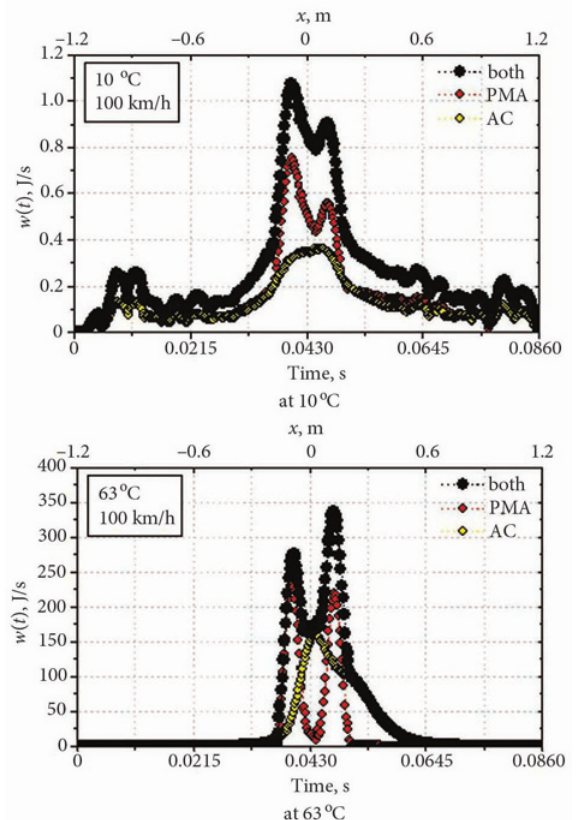
fig. 6. Evolution of the pavement structure-induced energy dissipation at 100 km/h for a 40 t truck